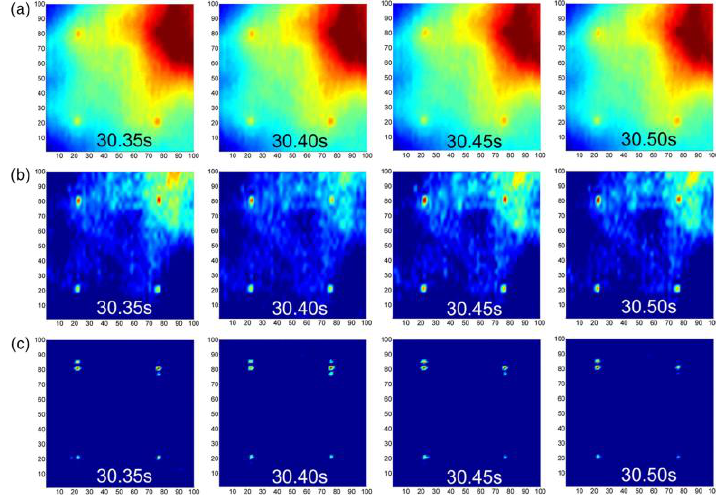
Figure 4. Comparison between PT thermal results from raw data ( a ); Differential Absolute Contrast (DAC) method ( b ) and Gapped Smoothing Algorithm (GSA) ( c ), with permission from 50.